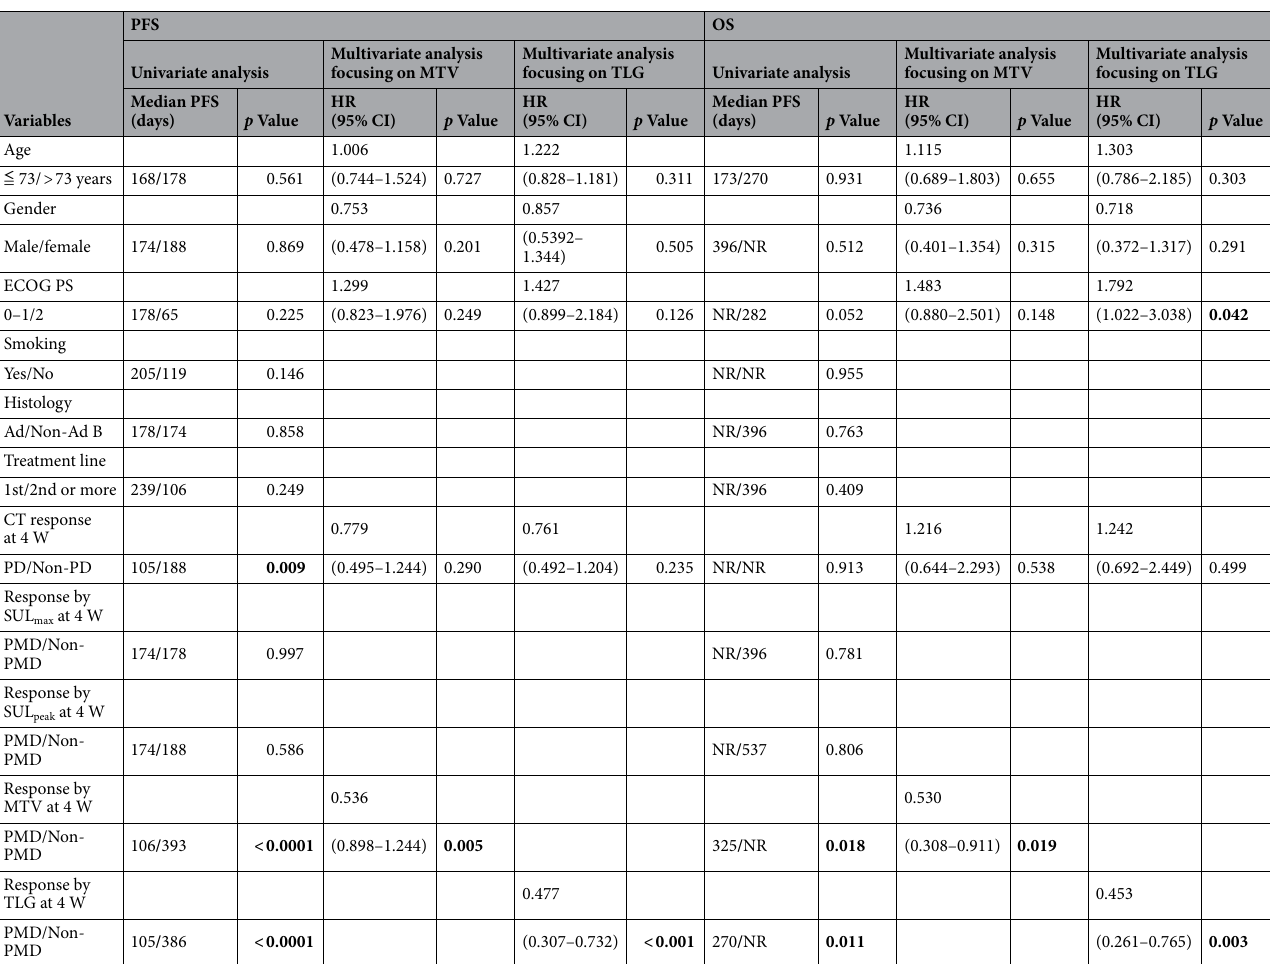
Table 2. Univariate and multivariate survival analysis from PD-1 blockade initiation in all patients. ECOG PS eastern clinical oncology group performance status, BI brinkman index, Ad adenocarcinoma, Non-Ad